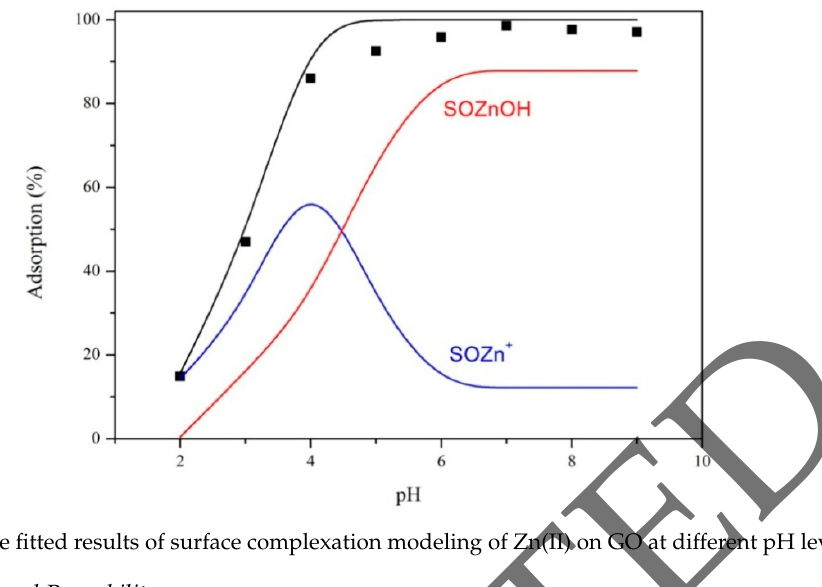
Figure 6. The fitted results of surface complexation modeling of Zn(II) on GO at different pH levels.